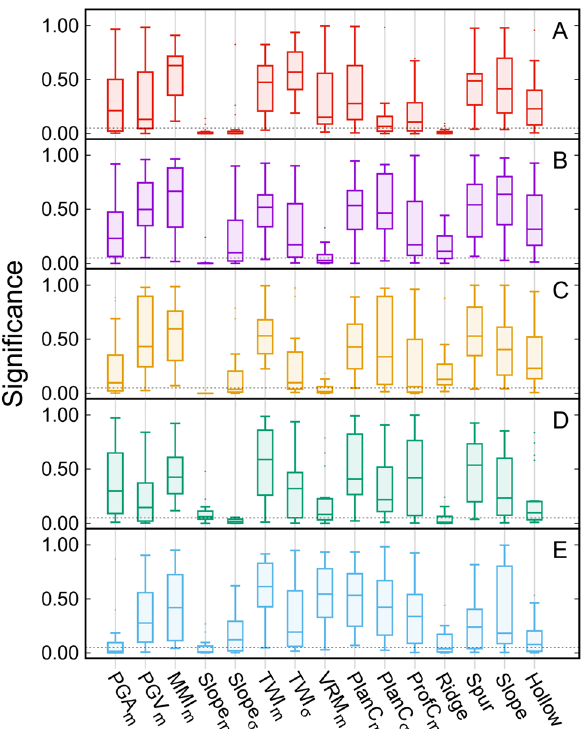
Figure 7. Significance of the different variables in terms of the p-value in LR, obtained from 20 iterations of the general linear model for each landslide inventory, initialized with corresponding random selections of the training sample. The horizontal dashed line represents the significance threshold adopted here (0.05).